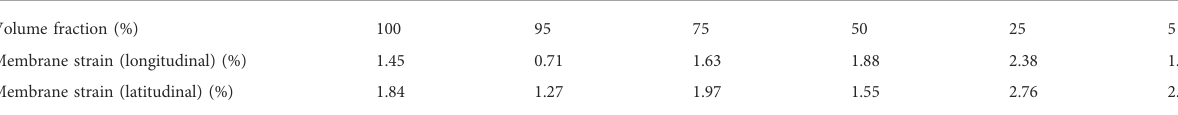
TABLE 3 Membrane strain during